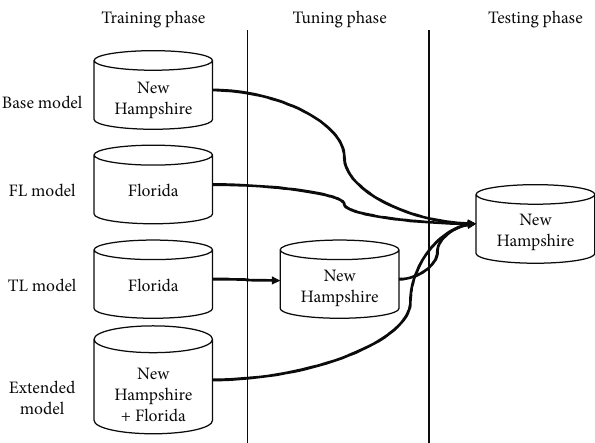
Figure 3: The outline of the experiments—Stage